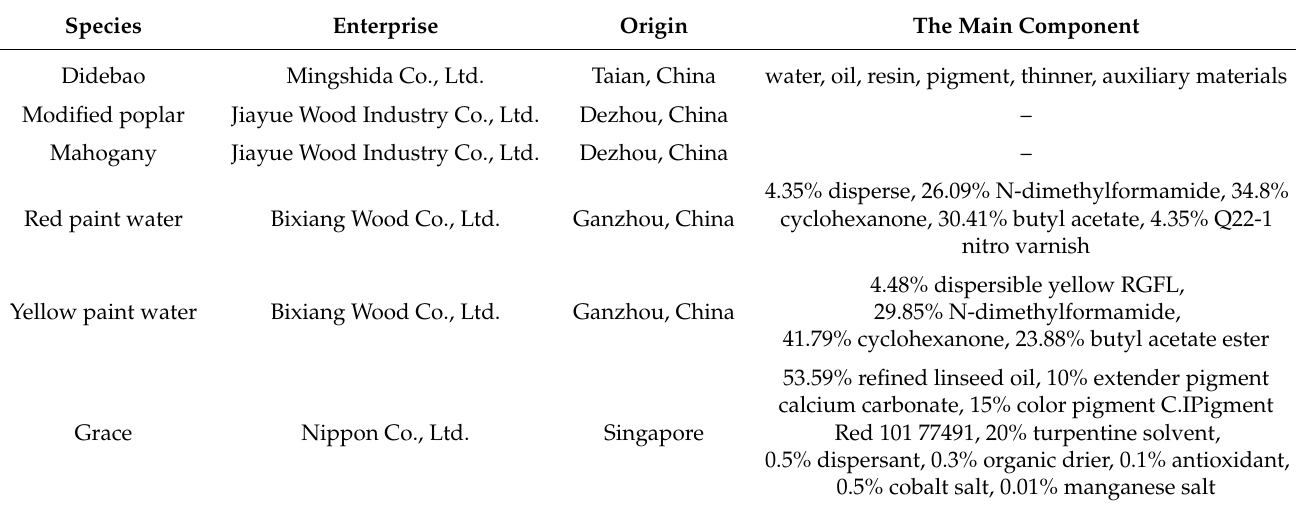
Table 1. The main component of species.